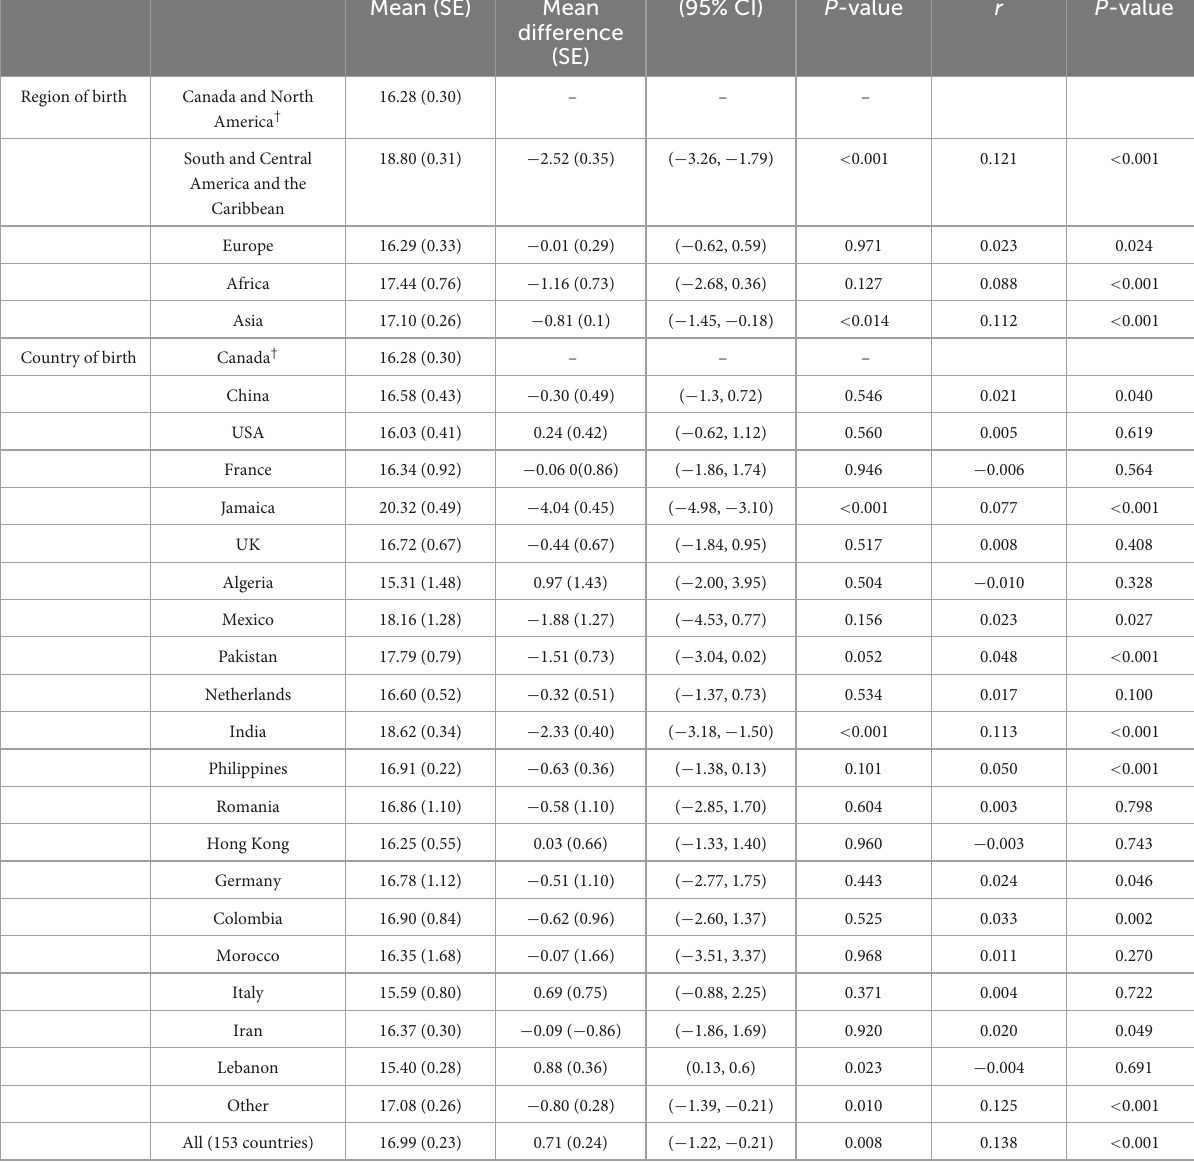
TABLE 3 Weighted mean melanin levels by geographical region and country of birth using Canadian Health Measures Survey (CHMS) data (Cycles 3 and 4).